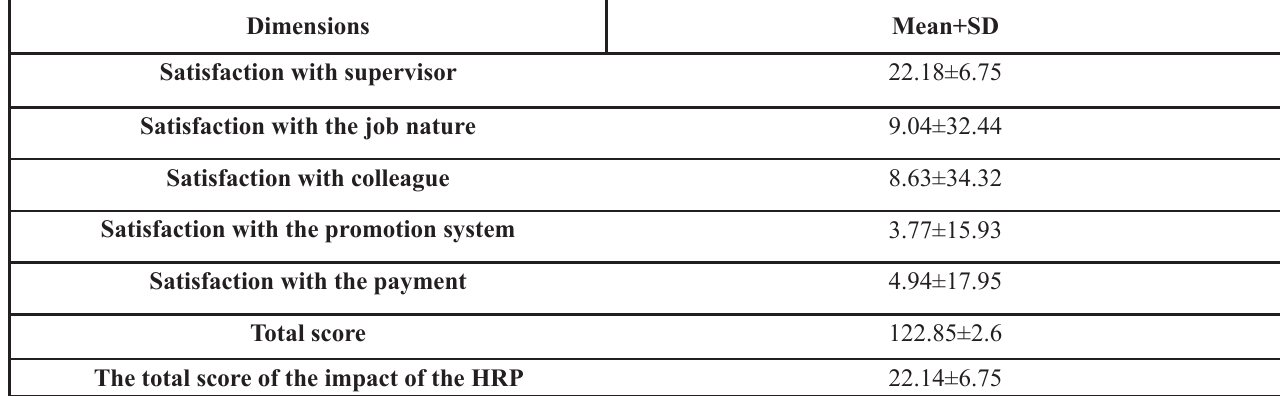
Table 2. Total score of job satisfaction questionnaire and the impact of the HRP